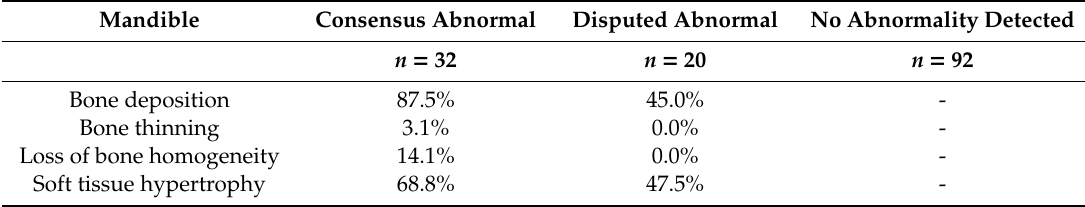
Table 6. The average of the two radiologists’ scores as percentage of the number of horses a ff ected. Types of radiographic lesion noted in those horses with consensus abnormal, disputed abnormal, and consensus normal radiographic films with respect to the mandibular lesions included in this